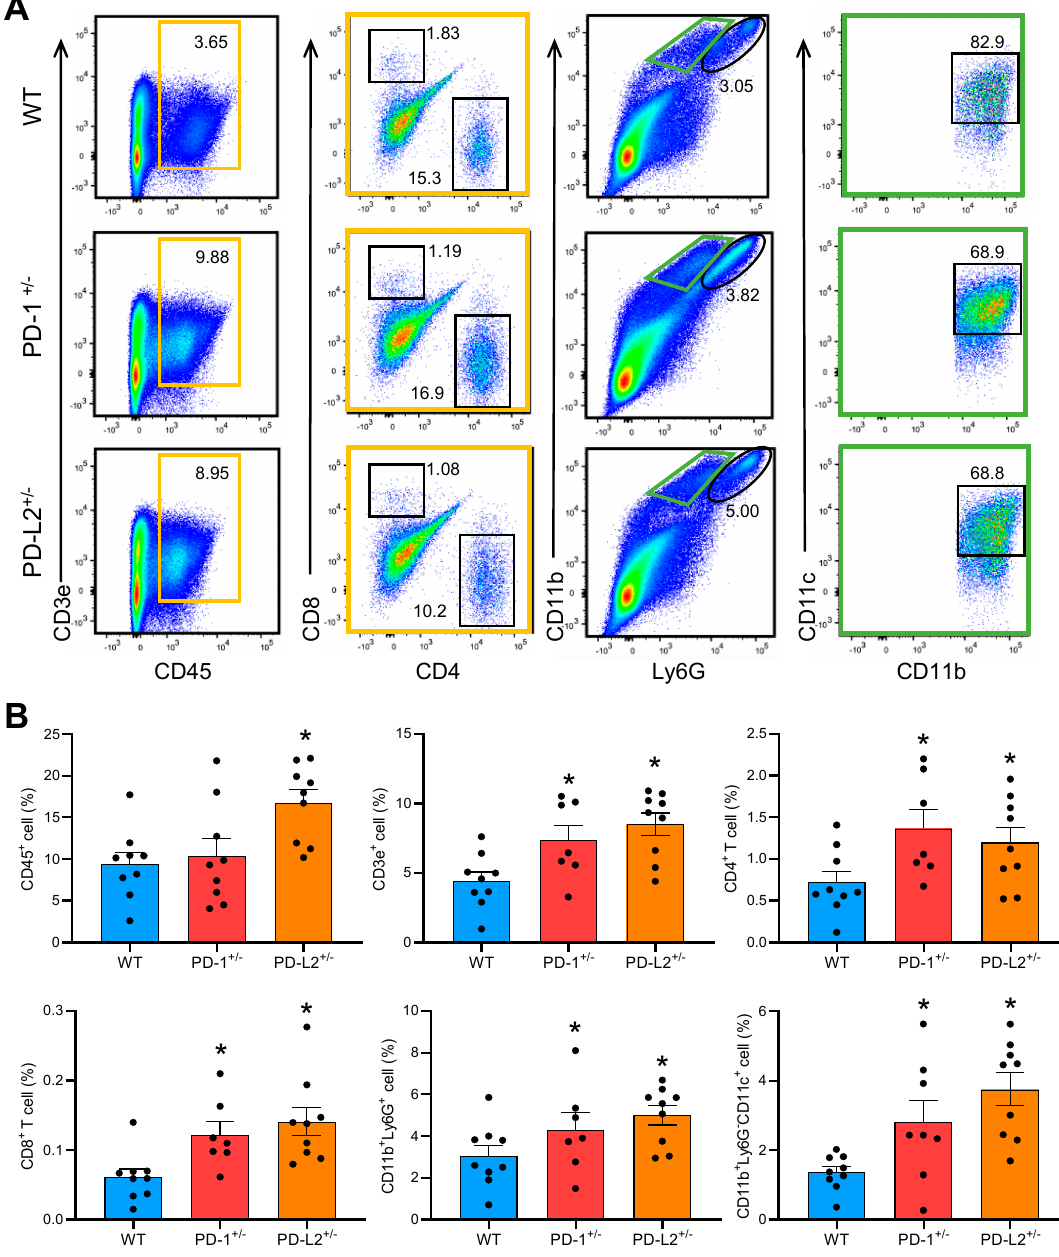
Figure 4. PD-L2 deficiency increases inflammatory cell infiltration in the experimental autoimmune myocarditis (EAM) heart. ( A ) Representative flow cytometric plots showing CD45 + leukocytes, CD3e + lymphocytes, CD8 + T cells, CD4 + T cells, CD11b + Ly6G + neutrophils, and CD11b + CD11c + DCs from WT, PD-1 +/ − , and PD-L2 +/ − hearts on day 14 after EAM induction. The orange squares indicate CD3e + CD45 + lymphocytes and the green squares indicate CD11b + Ly6G dull cells. ( B ) Quantification of inflammatory cells in the hearts obtained from WT mice as well as PD-1 +/ − and PD-L2 +/ − mice with EAM. Results are presented as the mean ± SEM, n = 7–9 per group. * p < 0.05 vs. WT.